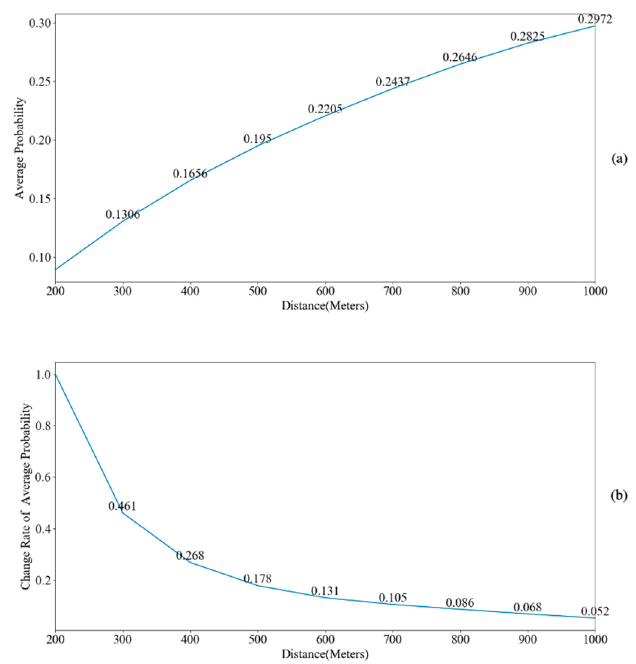
Figure 7. Attenuation of the probability of encounter with distance: ( a ) the average cumulative probability increases with distance; ( b ) the cumulative probability increment decreases with distance.